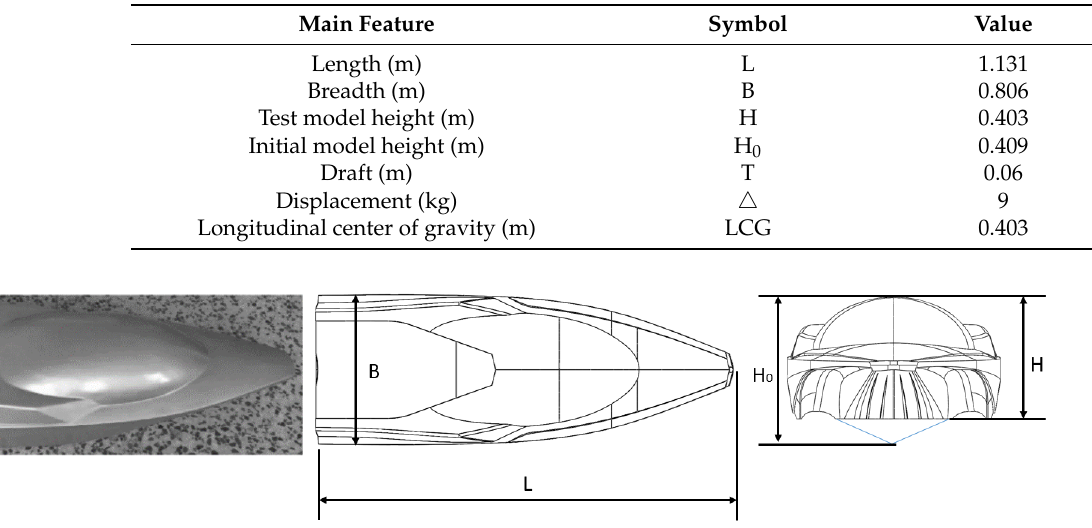
Figure 1. Wind tunnel test model.